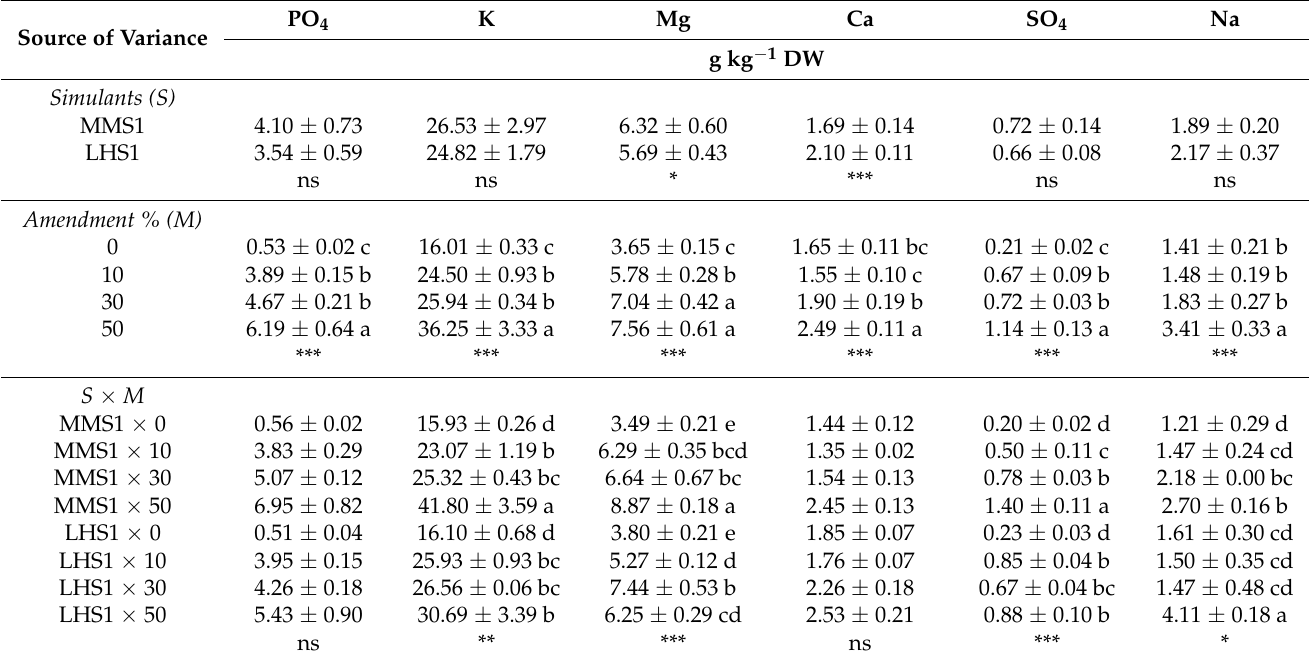
Table 6. Mineral contents in different mixtures of MMS-1 or LHS-1 simulants and manure (simu- lant/manure rates: 100:0, 90:10, 70:30, 50:50; w / w